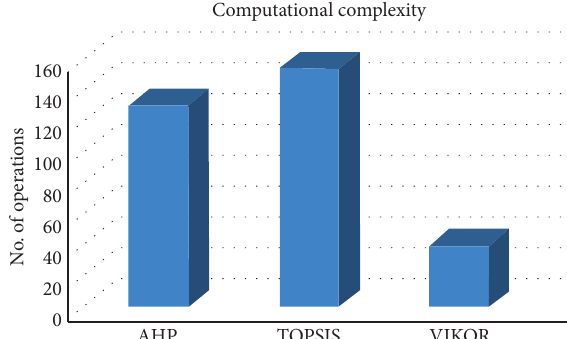
Figure 5: Computational complexity of approaches.